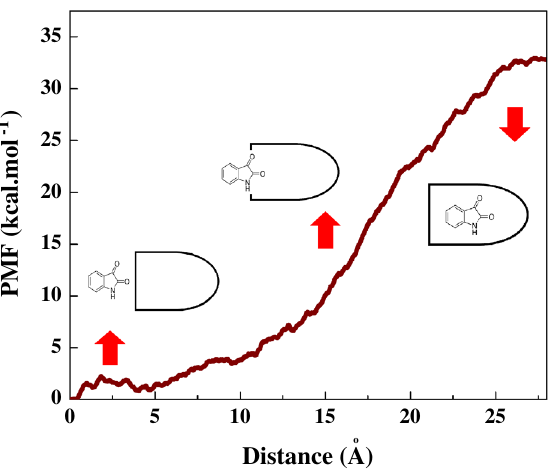
Figure 4. The PMF for the system comprised of a single Isatin guest molecule inside the capped SWCNT host computed from ten (10) pulling through the MD simulation . The images represent the positions of Isatin molecule corresponding to the z-coordinate along the capped SWCNT at a close proximity-, entering/exiting- and in a fully-enclosed position inside the SWCNT